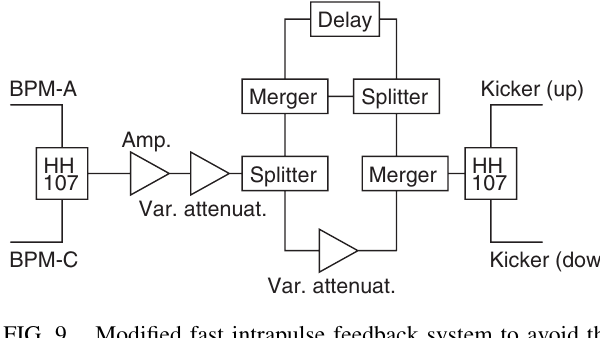
FIG. 8. (Color) Effect of the fast intrapulse feedback system on the beam blowup for different total latency (i.e. position) of the feedback system for the GLC and CLIC for an initial beam offset of 1 (cid:1) corresponds to a feedback system located (cid:13) 2 m ( (cid:13) 6 m ) away from the IP. Latencies of 30 (70) for CLIC corresponds to a feedback system located (cid:13) 2 : 8 m ( (cid:13) 5 : 8 m ) away from the